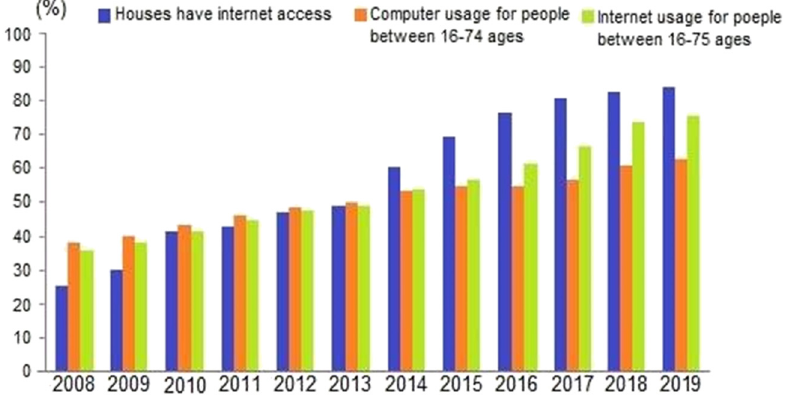
Figure 1: Percentage increase in internet and computer usage from 2008 to 2019.